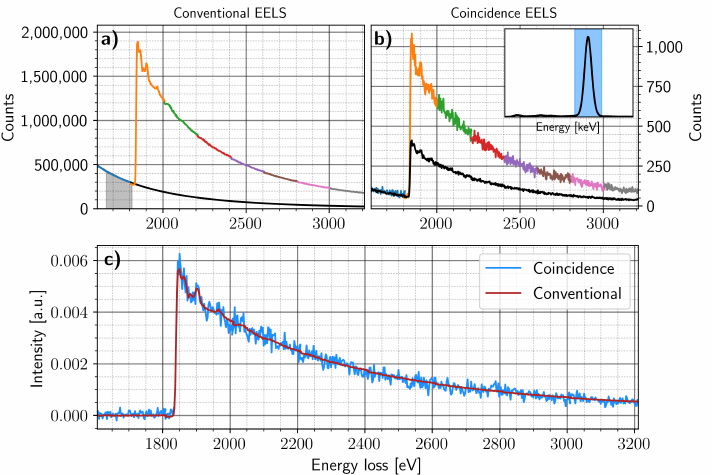
Figure 3. ( a ) Conventional EEL spectrum obtained from eight separate acquisitions in consecutive energy windows. The black line indicates the fitted background a using power law where the fitted area is indicated with the grey area. ( b ) The correlated EEL spectrum when using only electrons which have an Si X-ray detected within the time correlation window. In the inset figure, the X-ray spectrum is shown where the blue area indicates the energy of the X-rays selected which correspond to the X-rays from Si. The black line is the background signal obtained from using the electrons outside the time coincidence window. ( c ) The coincidence and conventional background-subtracted EEL spectra from which it is seen that the background subtraction method using the correlation with X-rays can reproduce the same result as using the conventional power-law subtraction method albeit at the expense of a lower count rate. Please note that for the correlated result, no assumptions on background shape and no pre-edge fitting region was